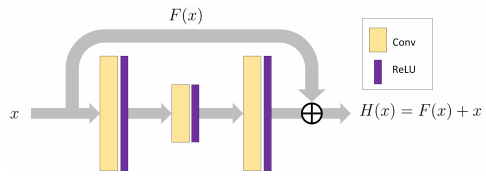
Figure 2. Schema of residual